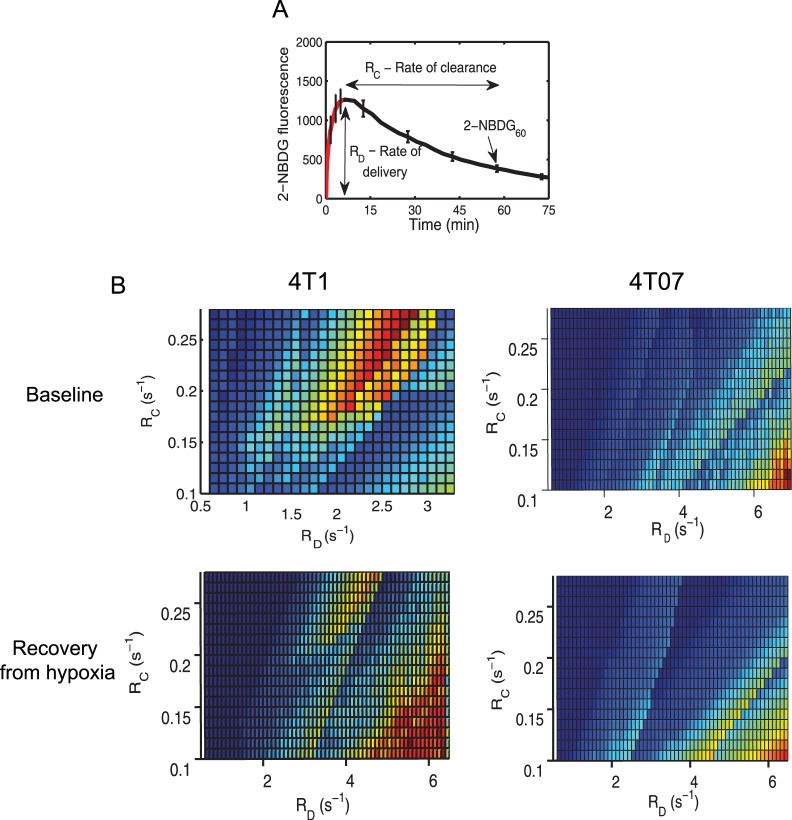
Relationship between SO2, RD, RC and 2-NBDG60 for 4T1 and 4T07 tumors.
A. Illustration of 2-NBDG uptake curve indicating how RD, RC and 2-NBDG60 are calculated. B. Contour plots showing the relationship between delivery, clearance and uptake of 2-NBDG. RD and RC represent the x- and y-axes, respectively, while 2-NBDG60 represents the z-axis projecting out of the x-y plane. For the 4T1 tumors at baseline, 2-NBDG60 increases with RD at low values of RC. At higher values of RC, 2-NBDG60 reaches a maximum at RD = 2.5 s−1, levels off and then declines gradually for increasing RD. After hypoxia, a secondary maximum is seen at very high values of RD (RD>6 s−1) and low RC. In the 4T07 tumors, 2-NBDG60 increases with RD and reaches a maximum at approximately 6 s−1. The same feature is also present after hypoxia. At higher values of RC, 2-NBDG60 was nearly negligible for increasing values of RC.